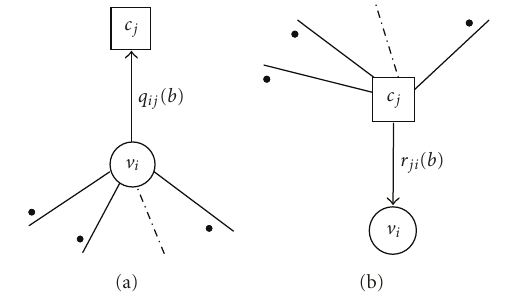
Figure 2: (a) Variable-to-check message, (b) check-to-variable